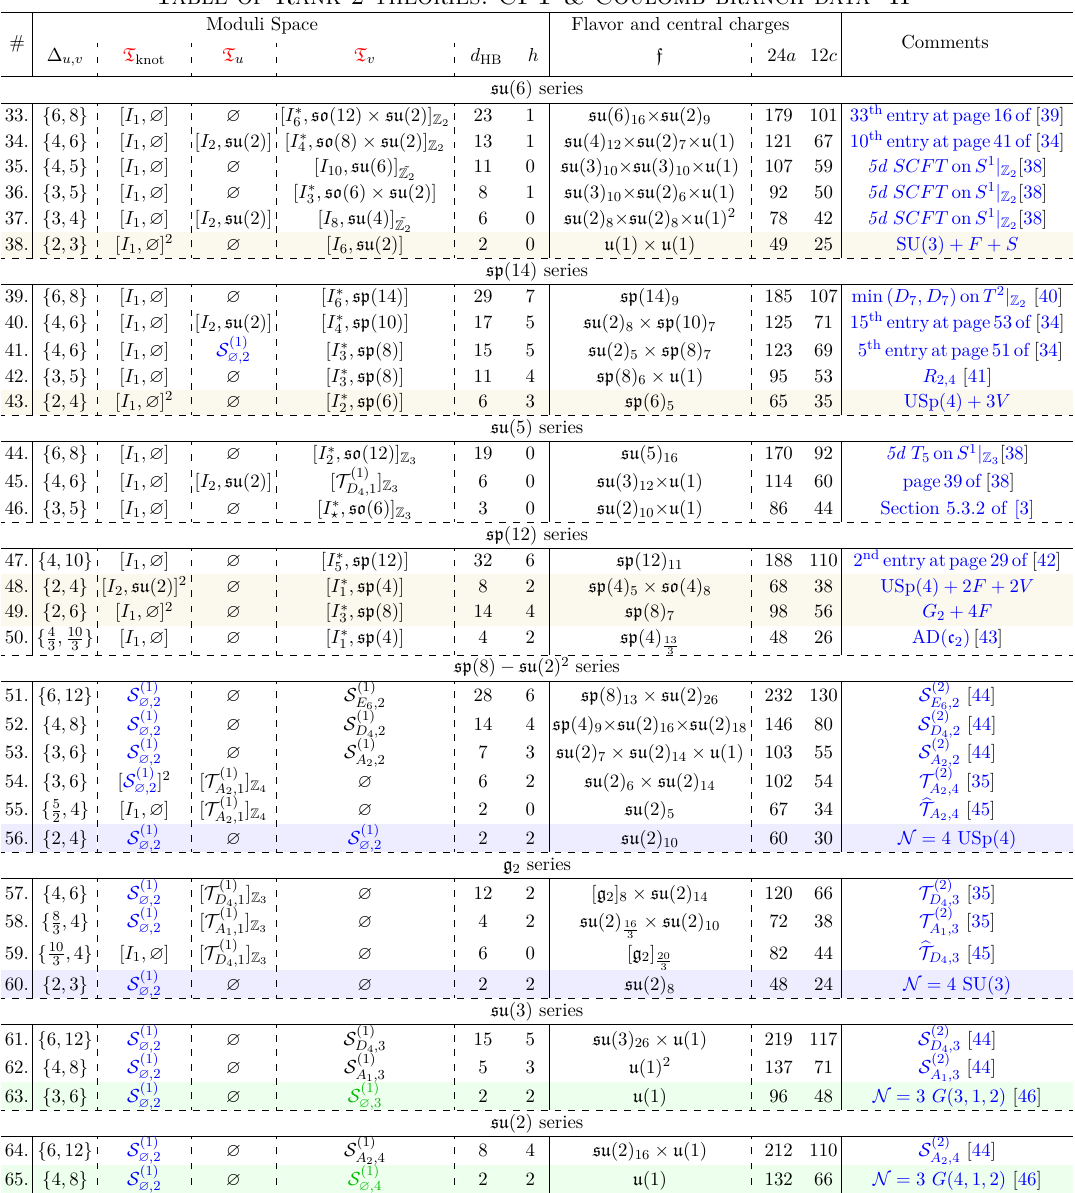
Table of Rank-2 theories: CFT & Coulomb branch data II